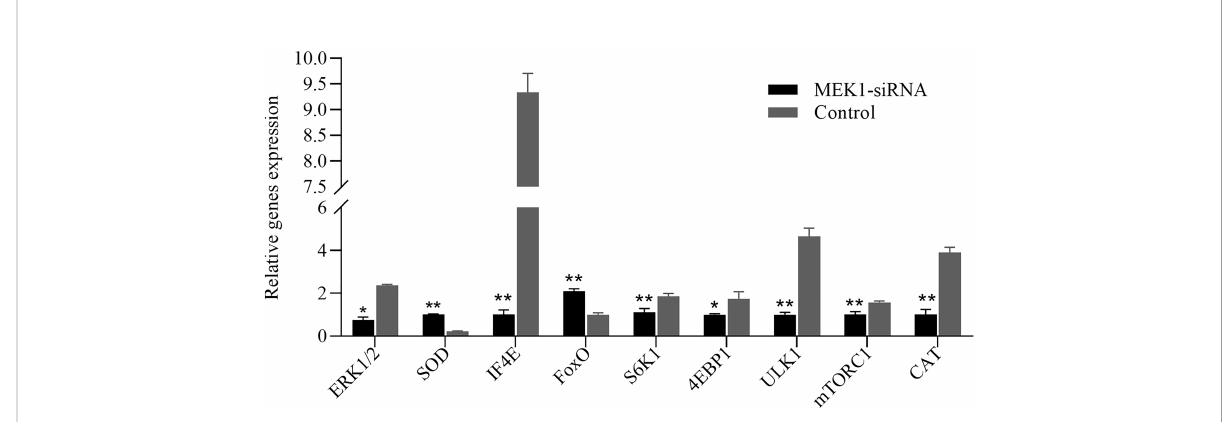
FIGURE 11 Relative expression levels of other aging-related genes after knockdown of AiiMEK1 gene expression (* p < 0.05 and ** p <